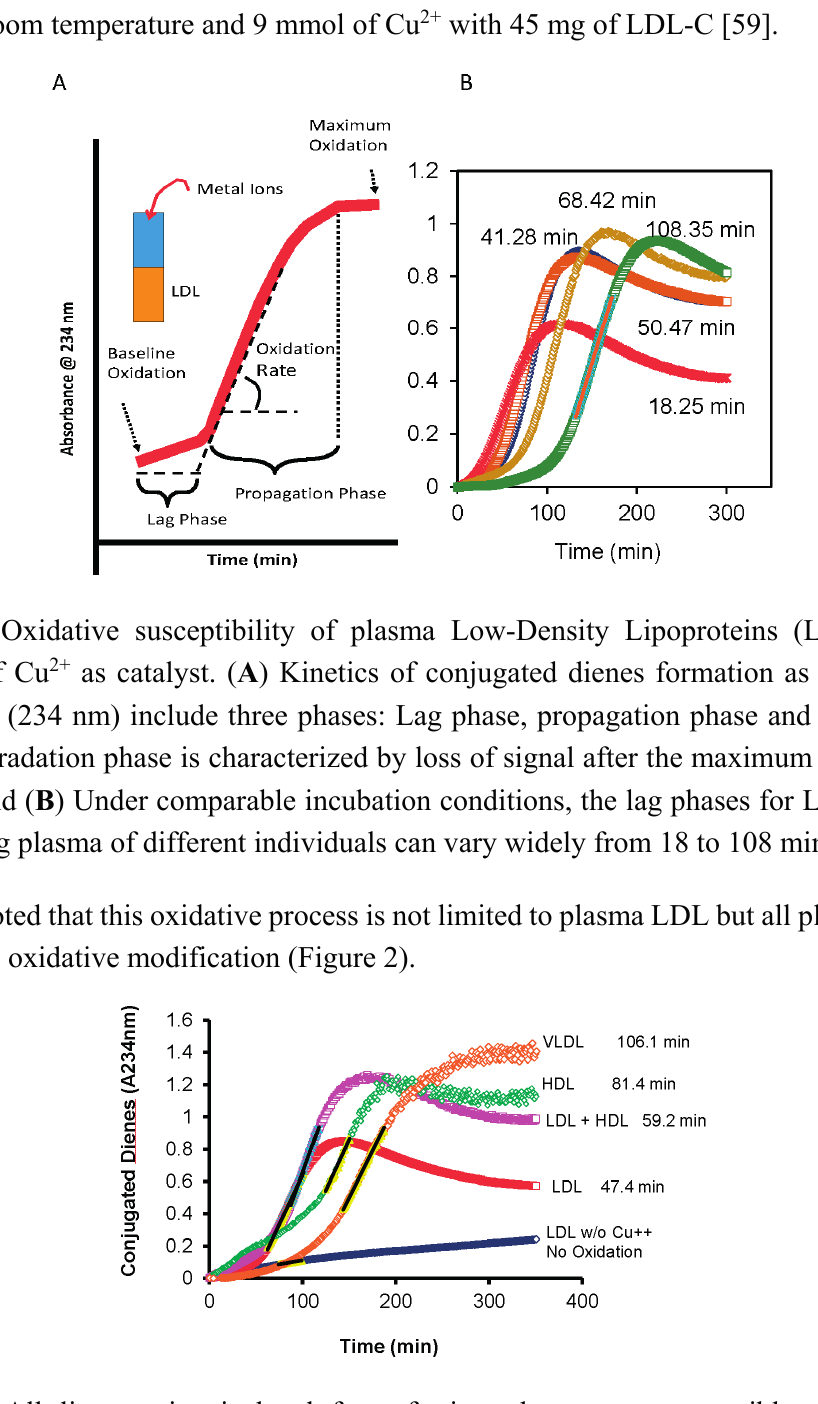
Figure 2. All lipoproteins isolated from fasting plasma are susceptible to oxidative modification in the presence of Cu 2+ as a catalyst. (VLDL: Very-low density lipoproteins; LDL: Low-density lipoproteins; HDL: High-density lipoproteins; See [59] for details on the isolation procedure and incubation